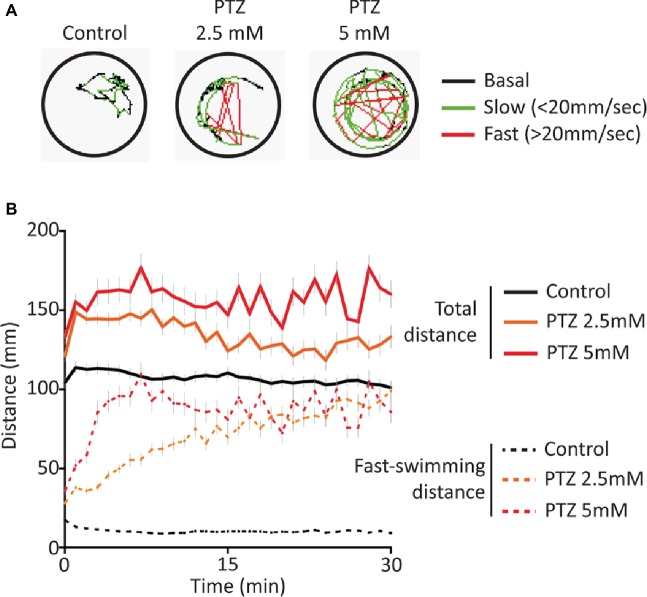
Behavioral response following acute exposure to PTZ. (A) Representative behavioral trace for 60 s from a single larvae. (B) Larval activity pattern as measured by average distance traveled (60 s time bins) immediately after introduction of PTZ (n = 144 for PTZ 2.5, n = 108 for PTZ 5, n = 252 for controls).